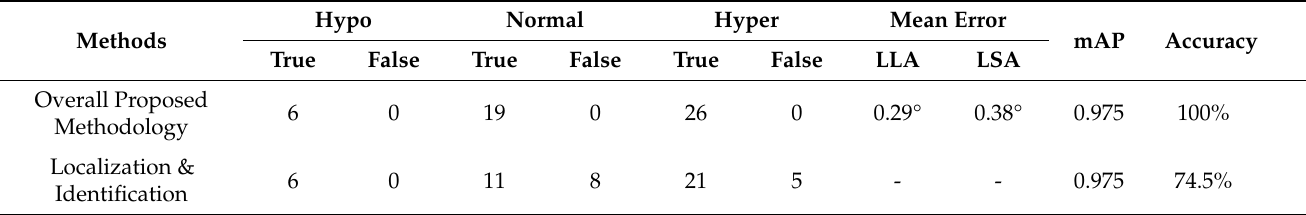
Table 7. Comparison table of two methods that were used to diagnose the lumbar lordosis. Lumbar lordosis assessment through corners outperforms the lumbar lordosis assessment through region area. We used the same localization part for both methods; therefore, the value of mAP in both methods is the